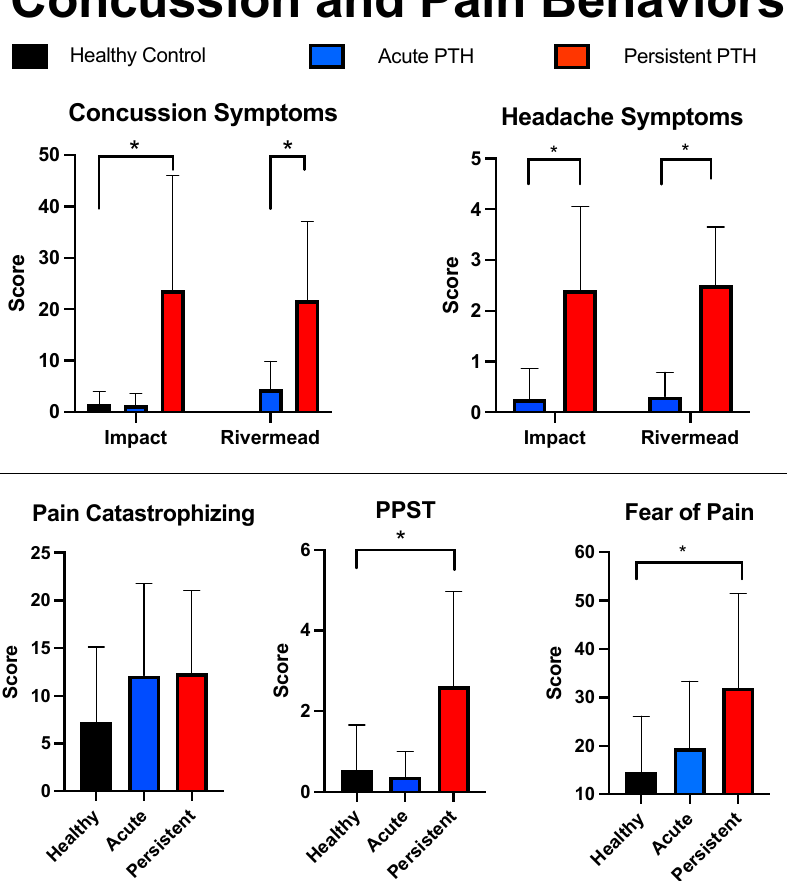
Figure 1. Self-reported symptoms. Findings are outlined for the three cohorts using mean and standard deviations for the main mTBI and pain questionnaires. mTBI symptom reporting is provided for the Impact and Rivermead mTBI surveys. * indicates a p -value less than 0.05.